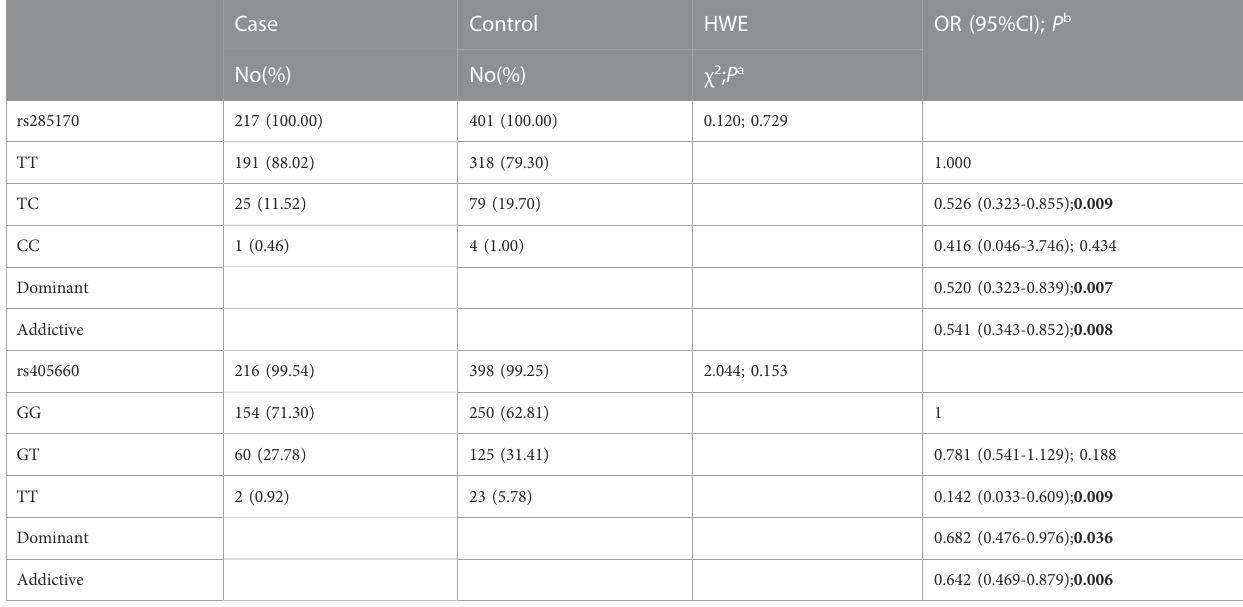
TABLE 3 Association between AS-related genetic variants and